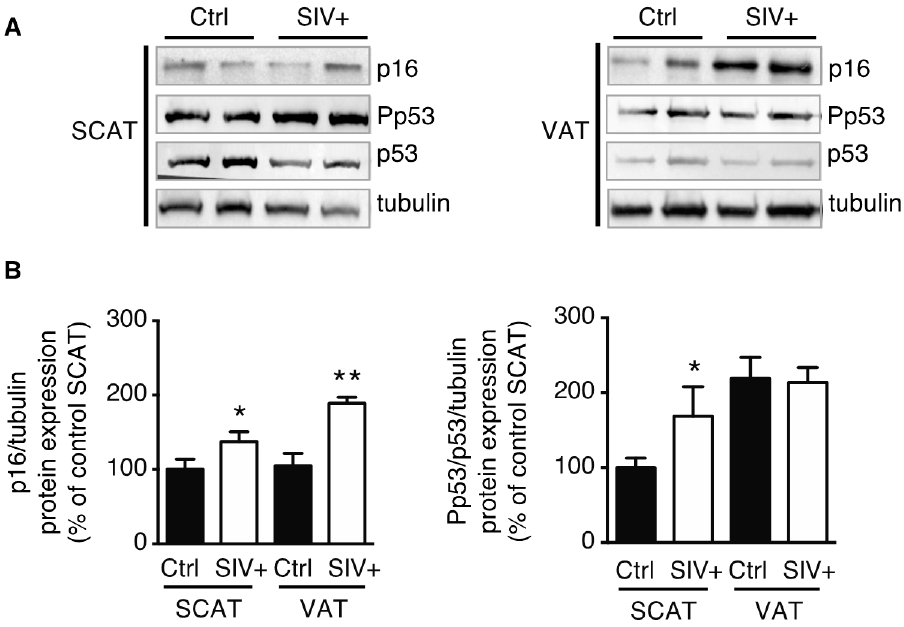
Figure 1. SIV infection of macaques was associated with higher expression of p16 and greater activation of p53 in the adipose tissue. Whole-tissue proteins were extracted from subcutaneous adipose tissue (SCAT) and visceral adipose tissue (VAT) from chronically infected macaques and controls and then analyzed by immunoblotting. ( A ) Representative immunoblots of p16, phosphorylated-p53, p53, and tubulin (loading control) are shown. ( B ) Densitometry analyses against tubulin as loading control were performed for p16 and p53 activation, and expressed as a mean ± SEM. Experiments were performed using SCAT and VAT from macaques from three control uninfected macaques (Ctrl) and four SIV-infected macaques (SIV + ). * P < 0.05, ** P < 0.01 vs. noninfected